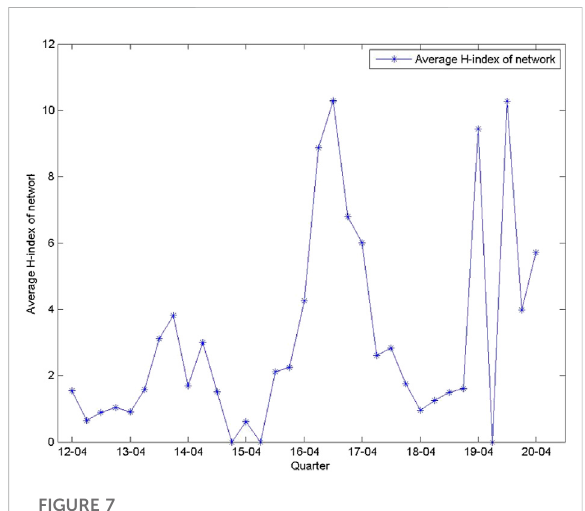
FIGURE 6 Quarterly changes in the average number of betweenness in China ’ s auto fi nance market network from 2012 to 2021.